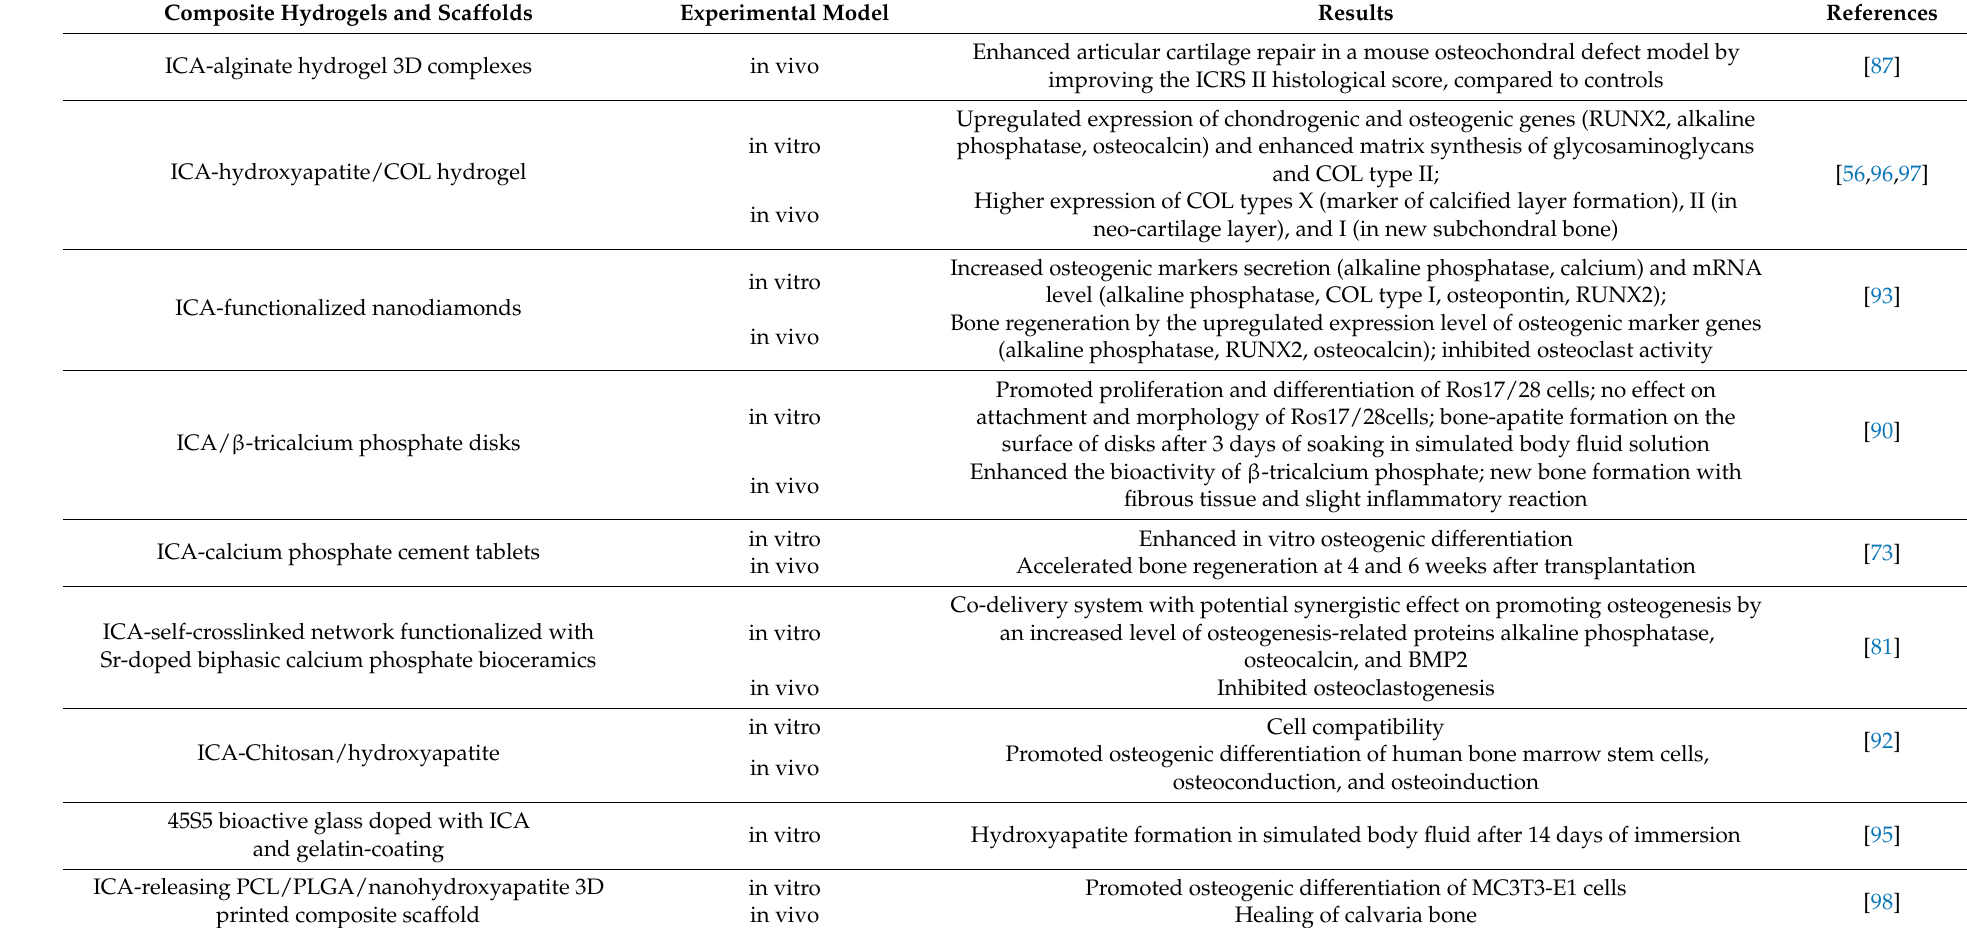
Table 1. Composite hydrogels and scaffolds loaded with ICA for osteochondral defects